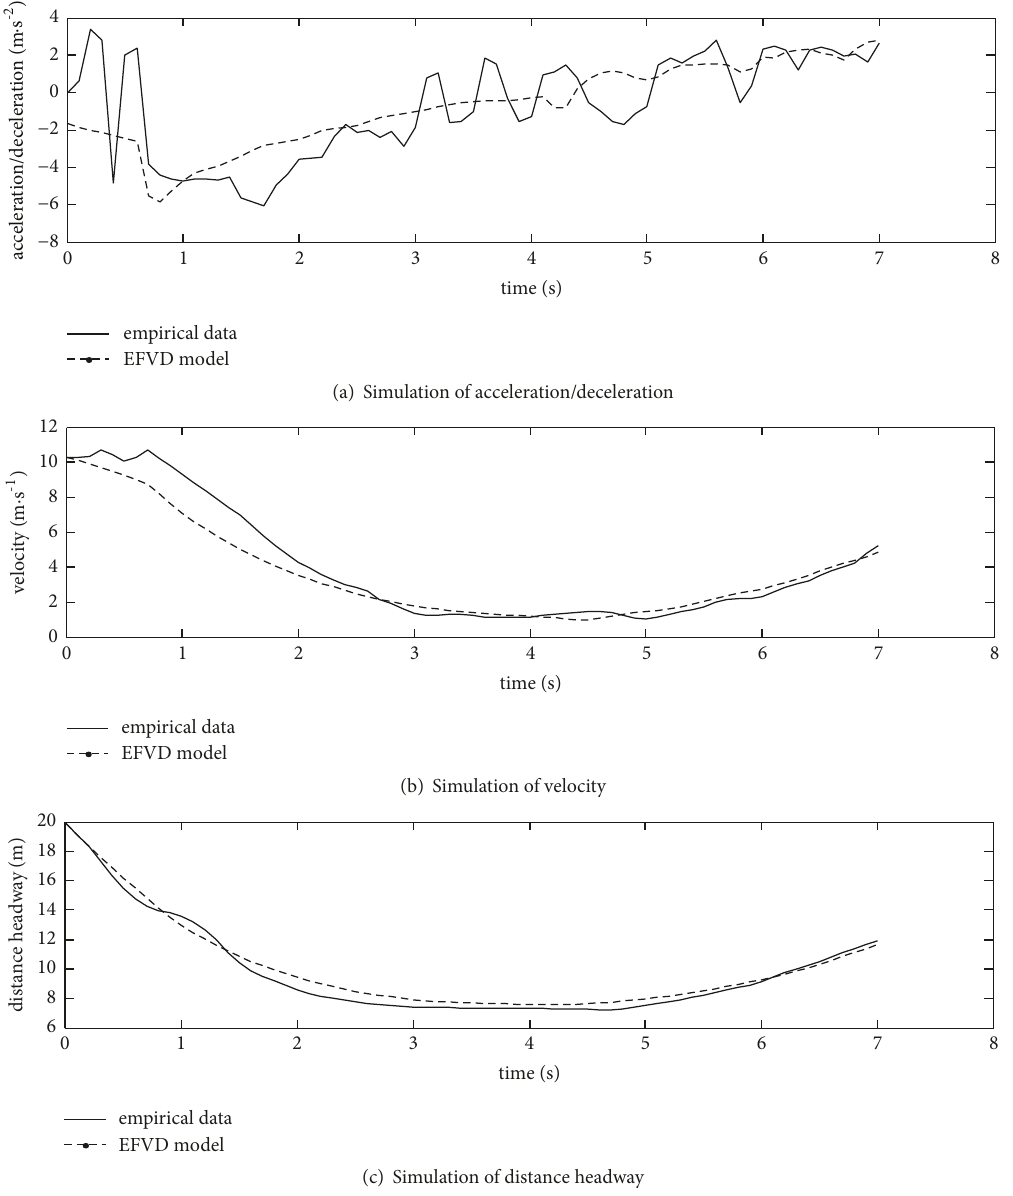
Figure 9: EFVD model simulations of car-following Process